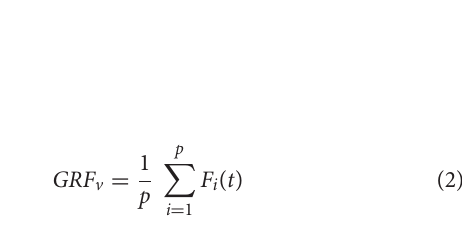
FIGURE 6 | Data processed using the DAS. (A) Data from each sensor placed on the instrumented insole. (B) Ground reaction forces obtained with SAD.